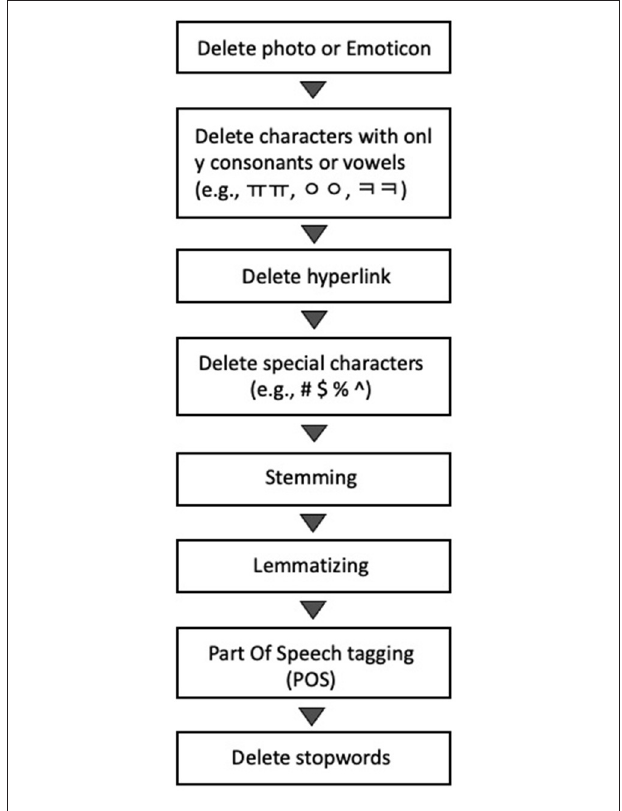
FIGURE 1 | Preprocessing